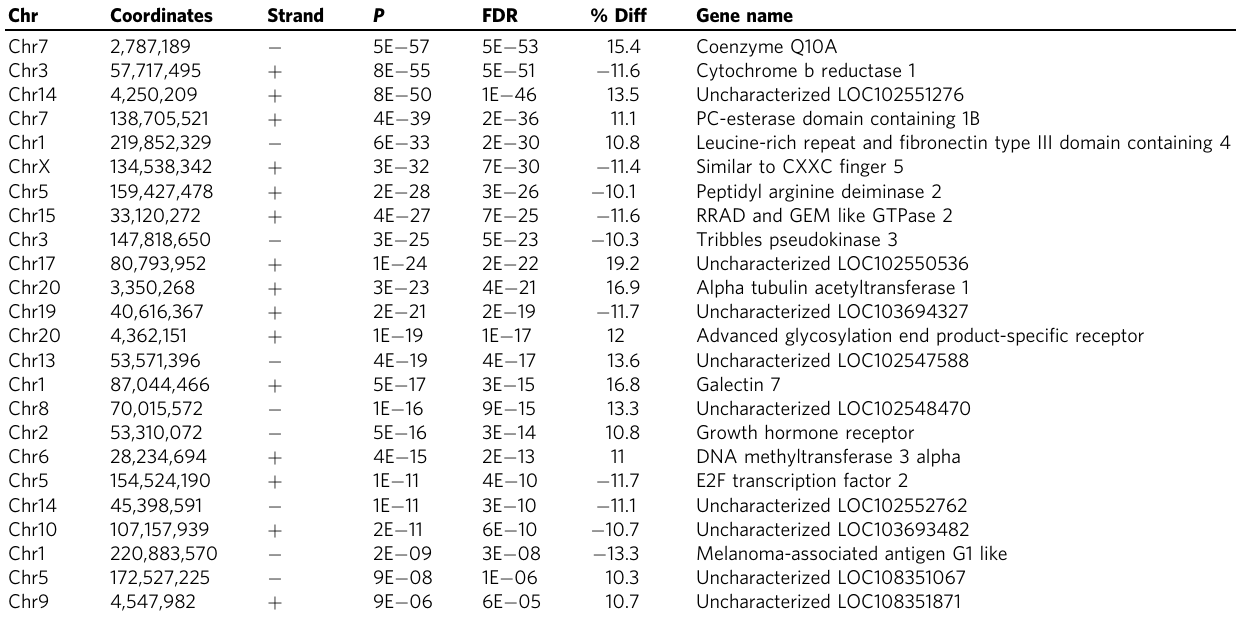
Table 4 Differentially methylated CpG sites located at gene